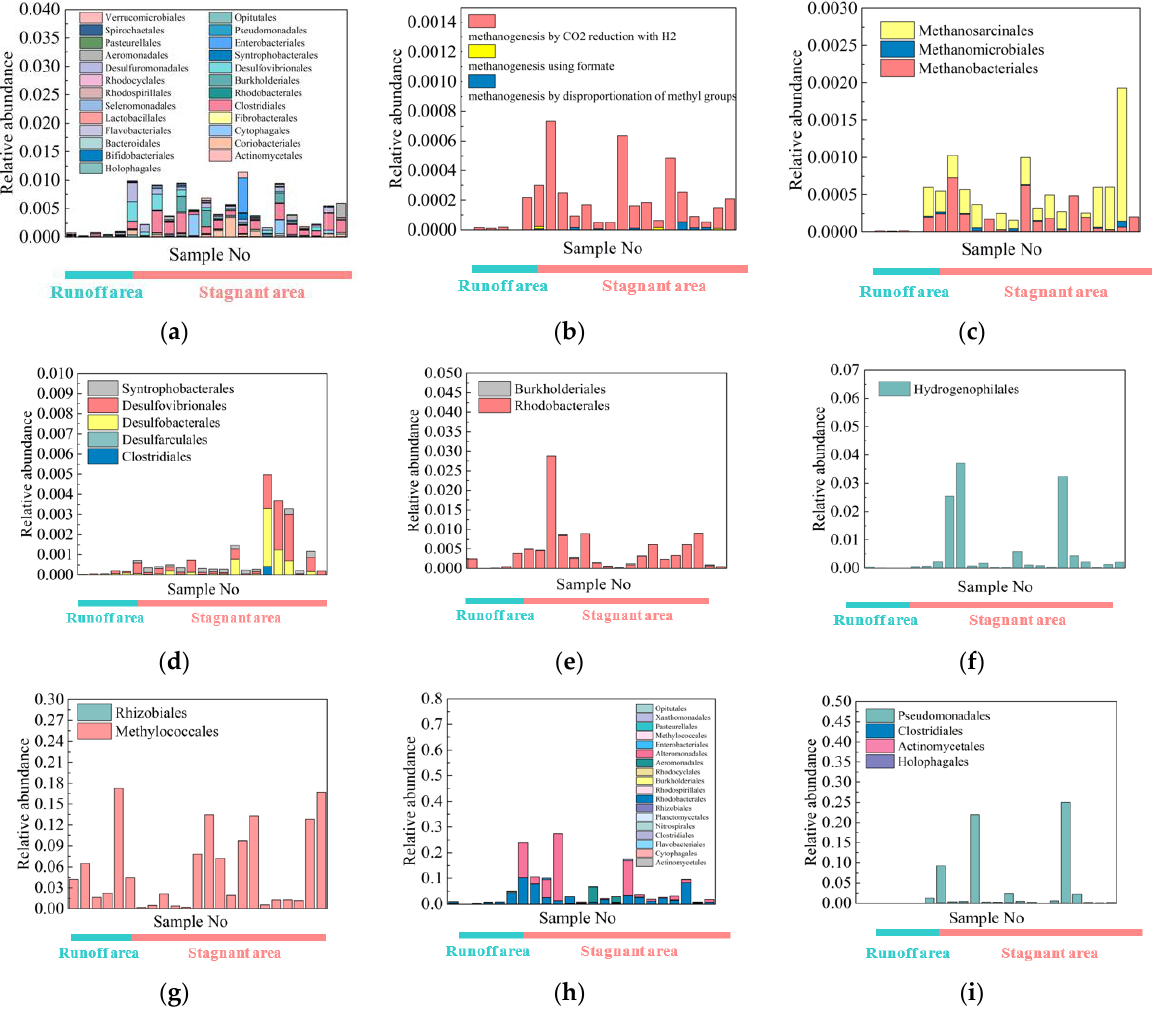
Figure 6. Histogram of relative abundance of C-N-S microorganisms in the study area: ( a ) fermen- tation bacteria; ( b ) different types of methanogens; ( c ) methanogens; ( d ) sulfate-reducing bacteria; ( e ) denitrifying bacteria; ( f ) dark sulfide oxidation bacteria; ( g ) methanotrophs; ( h ) aerobic chemo- heterotrophic bacteria; ( i ) aromatic compound degradation.